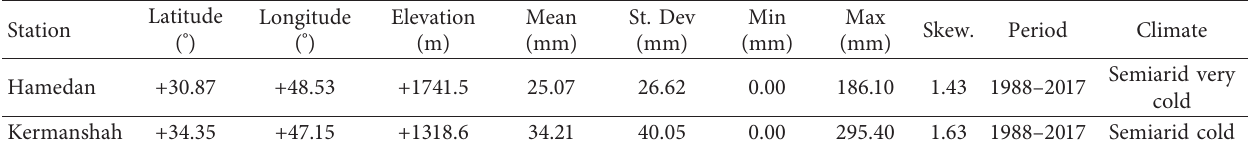
Figure 1: The geographical location of Hamedan and Kermanshah provinces. Table 1: Coordinates of the stations; descriptive statistics of the monthly precipitation time series; climate type based on the extended De- Martonne classification method